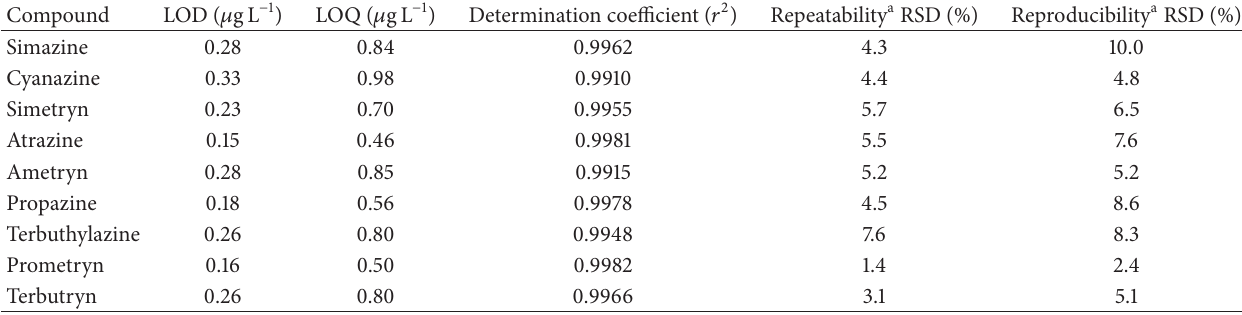
Table 1: Analytical characteristics of the SPE-HPLC method.